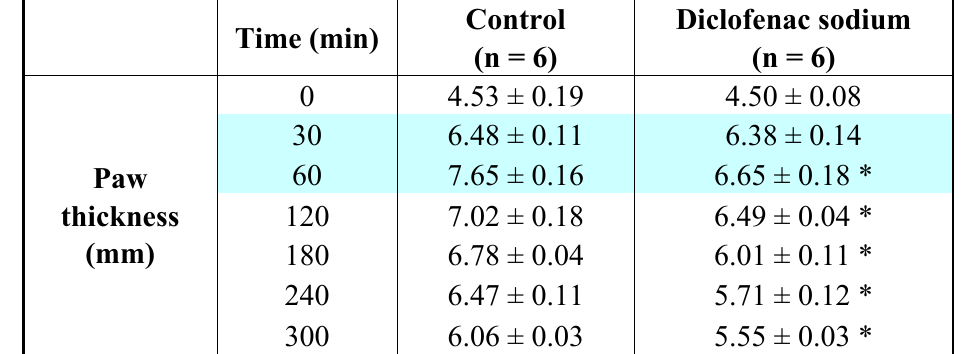
Table 1. Effect of diclofenac sodium (reference) and propylene glycol (control) on egg- white induced paw edema in rats.